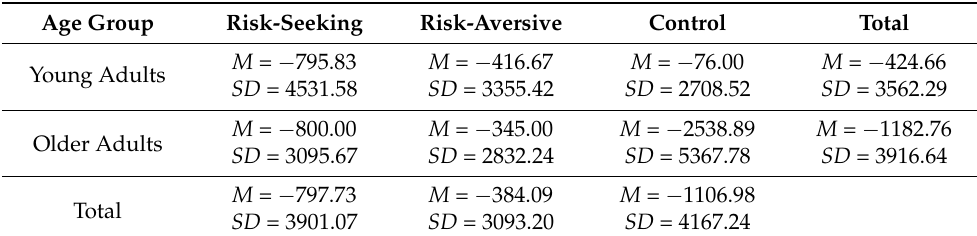
Table 2. Age and scenario differences in money